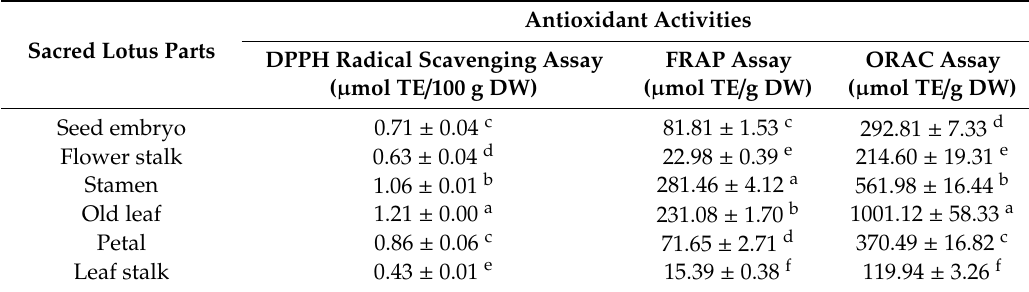
Table 5. Antioxidant activities for di ff erent parts of sacred lotus ( Nelumbo nucifera ).